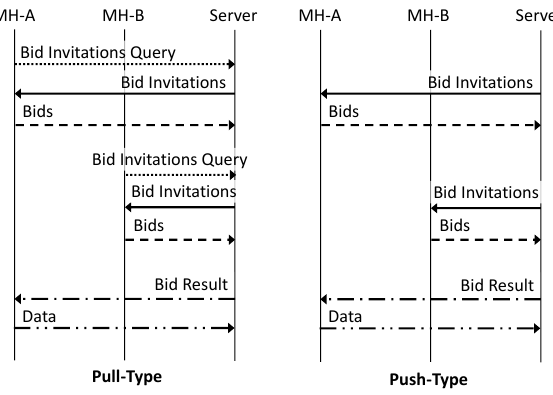
Figure 2. Sequence of pull-type and push-type RevAuc.